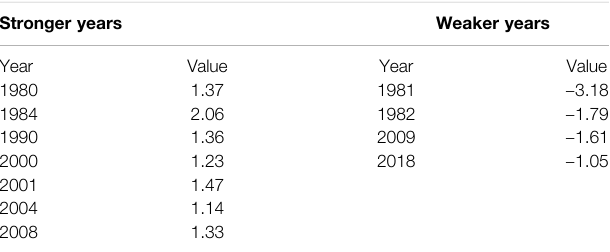
Frontiers in Earth Science |